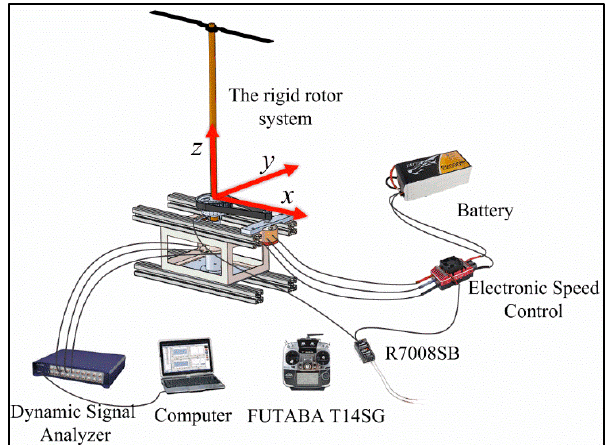
Figure 5. Connection diagram of vibration measurement system.